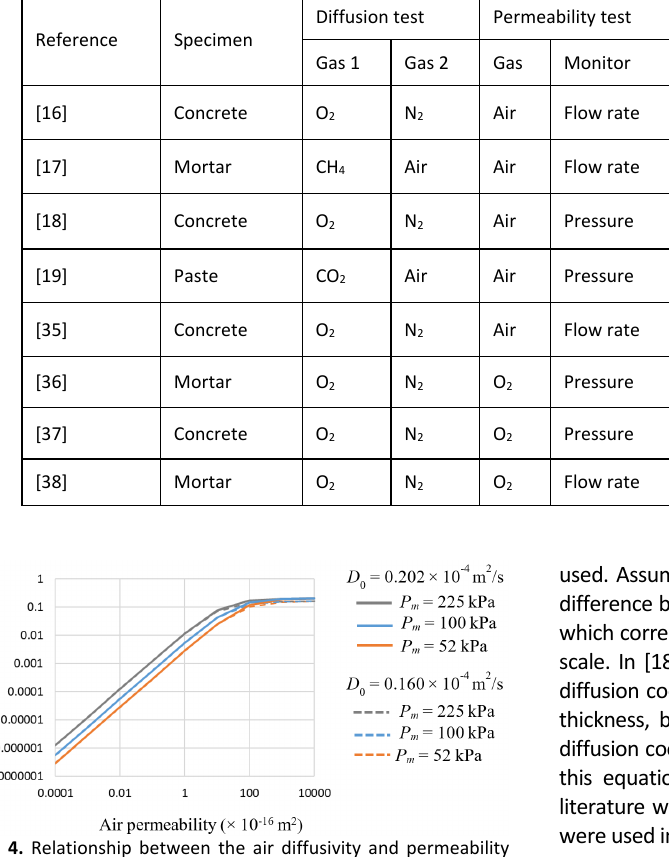
Figure 4. Relationship between the air diffusivity and permeability described by Eq. (9) with different values of D 0 and P m